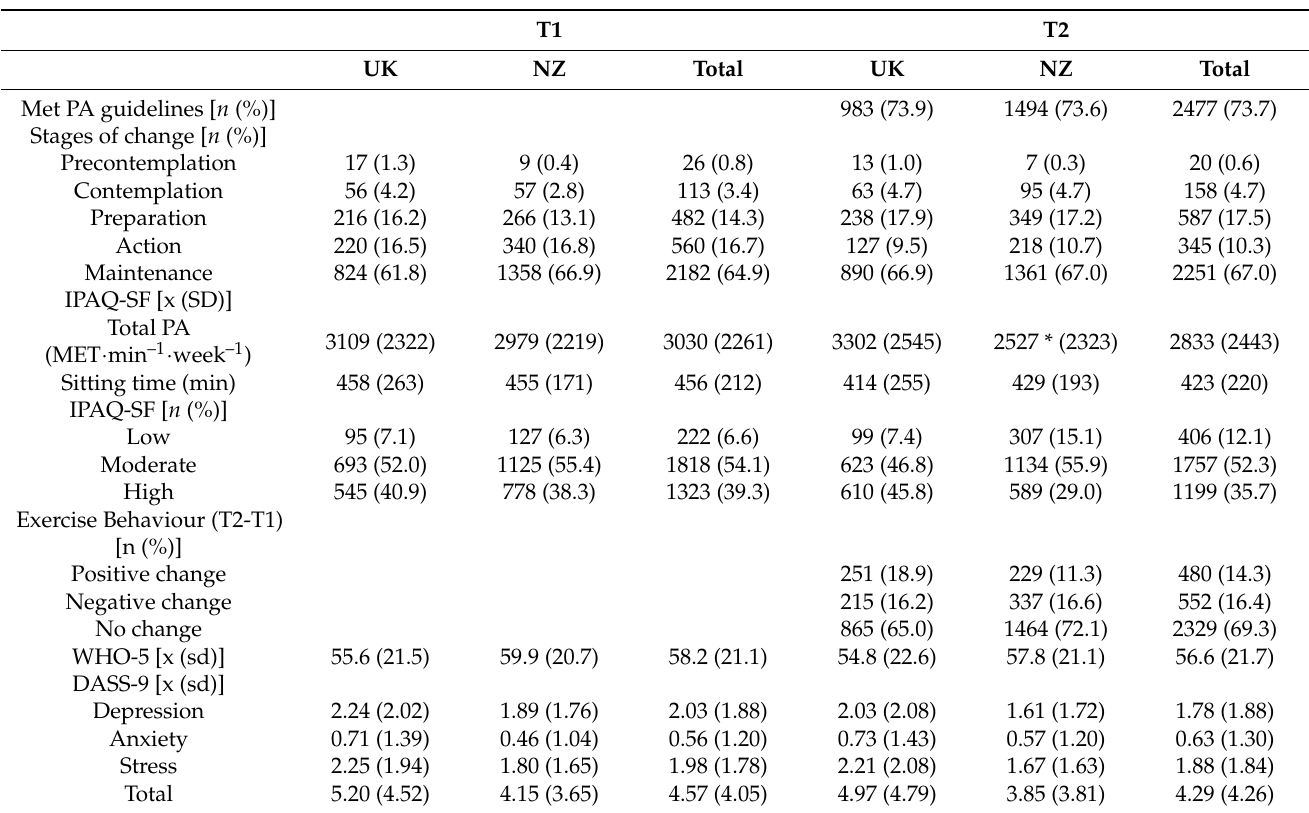
Table 2. Physical activity (IPAQ-SF), mental health (DASS-9) and wellbeing (WHO-5) for T1 and T2 for UK, NZ and total respondents. Data presented as n (%) or Mean